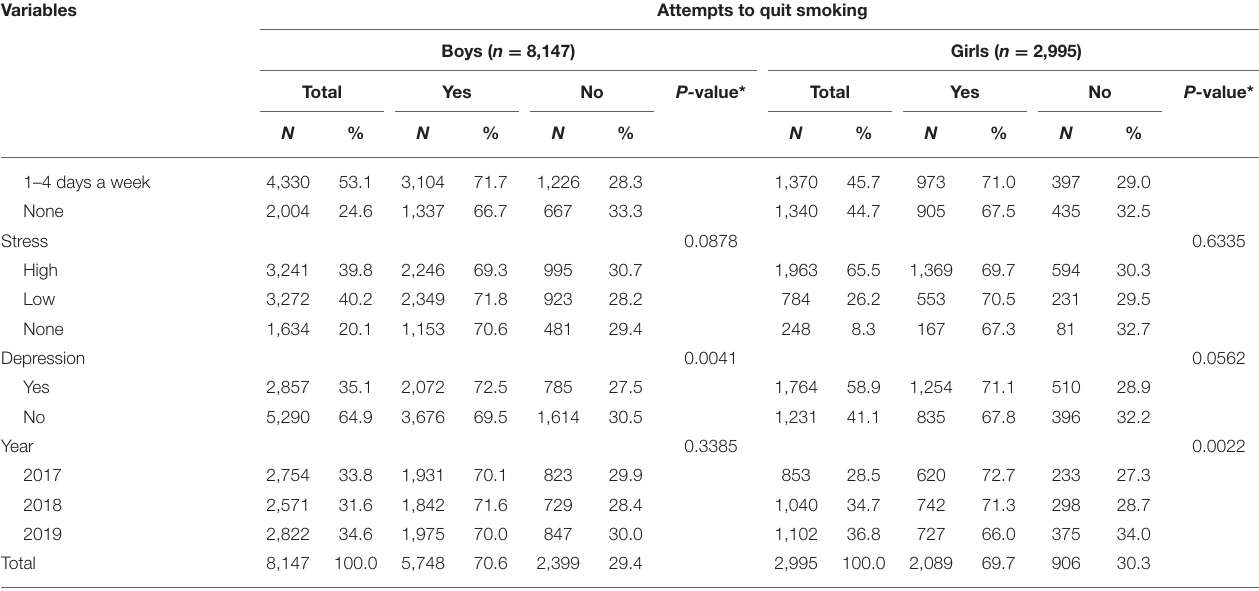
boys and girls. Compared with those of the reference group (having not seen GHWL), the ORs (95% CIs) for attempts to quit smoking in the group with having seen GHWL were as